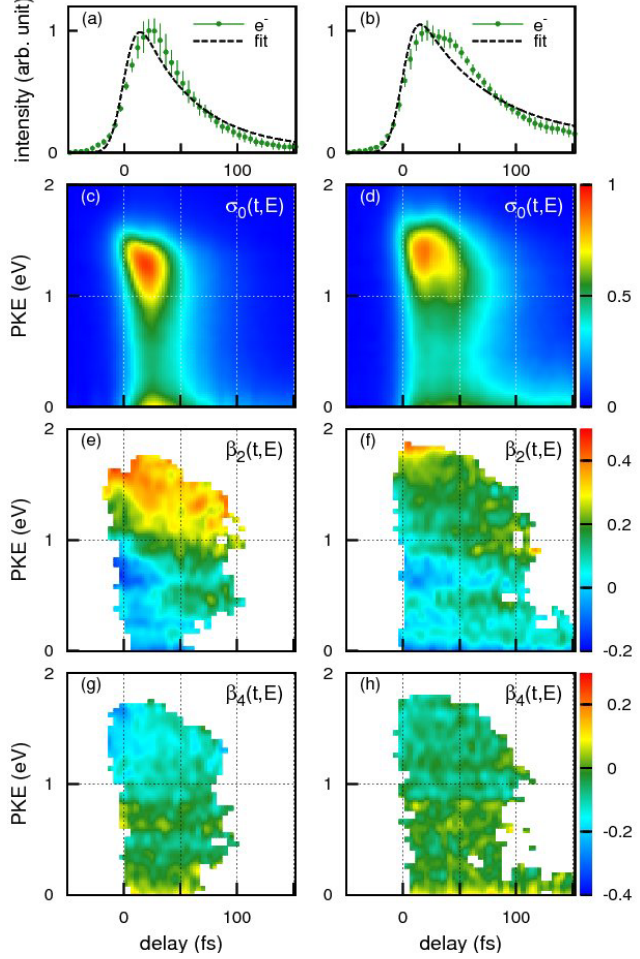
Figure 15. The time profiles of the photoionization signal intensity for ( a ) benzene and ( b ) toluene. Photoelectron signals are indicated by green dots with error bars. Time-energy maps of the photoelectron intensity, σ ( t , E ), for ( c ) benzene and ( d ) toluene. Time-energy maps of the photoelectron angular anisotropies, β ( t , E ) for ( g ) benzene and ( h ) toluene. Data points for β β 4 smaller than 0.2 are shown (see text). Reproduced with permission from Ref.